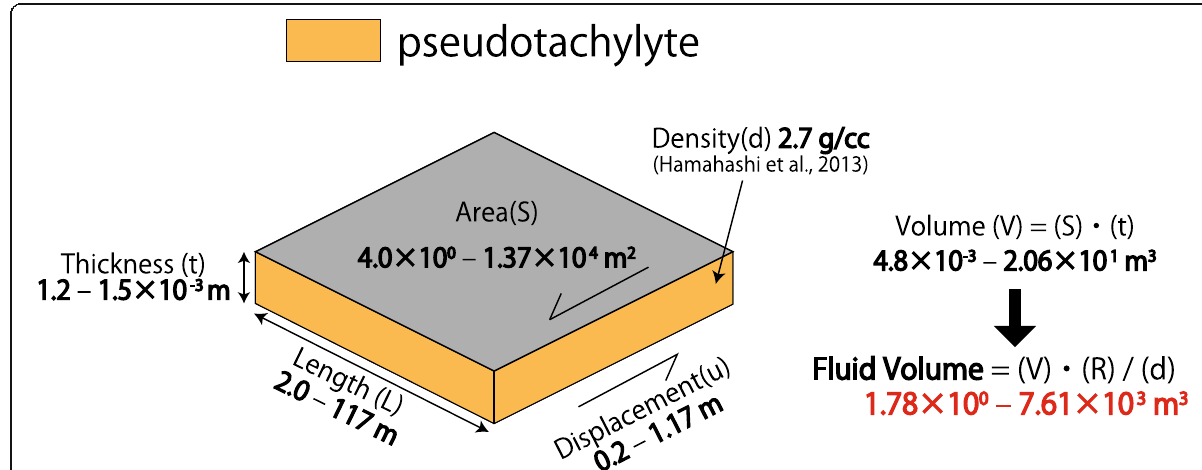
Fig. 10 Estimation of fluid volume that reacted with fault rock containing pseudotachylyte. Fault displacement of pseudotachylyte was estimated from a plot of fault thickness vs. displacement (Di Toro and Pennacchioni 2005). Fault length was estimated from fault displacement by the plot of fault displacement and length (Kim and Sanderson 2005). The fault area was assumed to be the square of the fault length, and the volume was calculated by multiplying the fault area by the thickness. Finally, the fluid volume was calculated from the calculated volume using the R value (1000 for simplicity) and the density of the fault